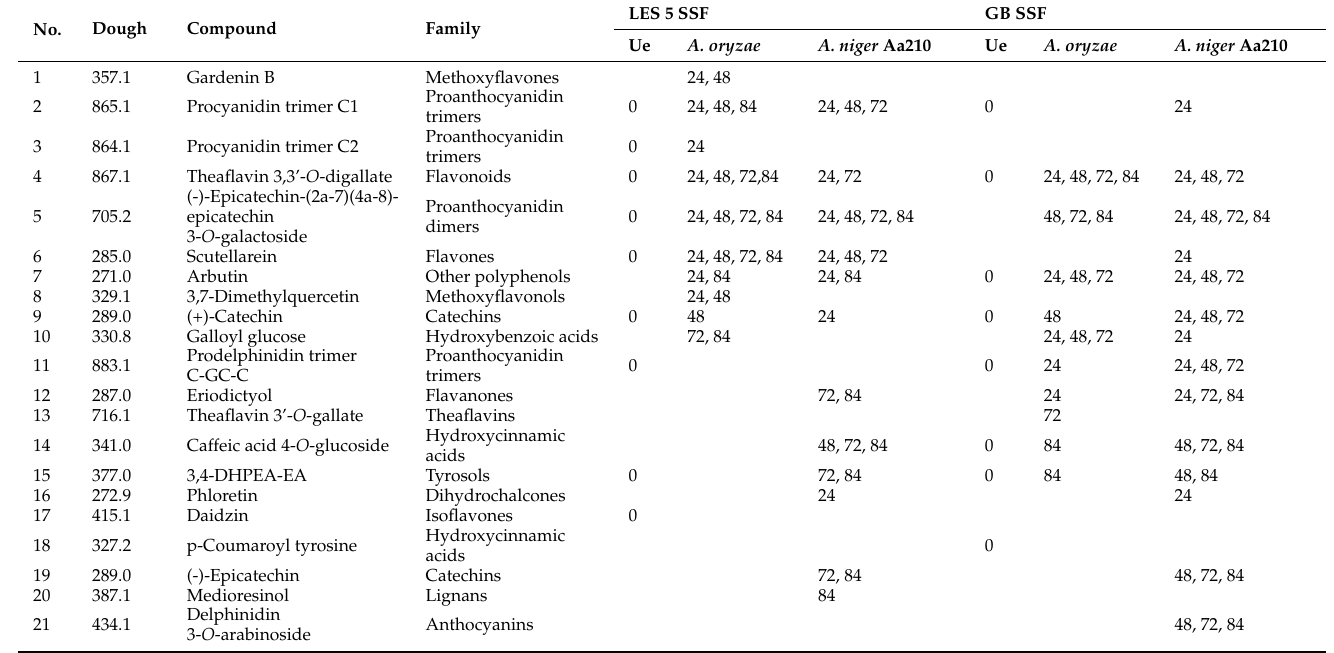
Table 4. Polyphenolic compounds identified by HPLC-MS in grain extracts of two sorghum geno- types in SSF by A. oryzae and A. niger Aa210 after 0, 24, 48, 72, and 84 h of fermentation. Time 0 Ue = unfermented extract.